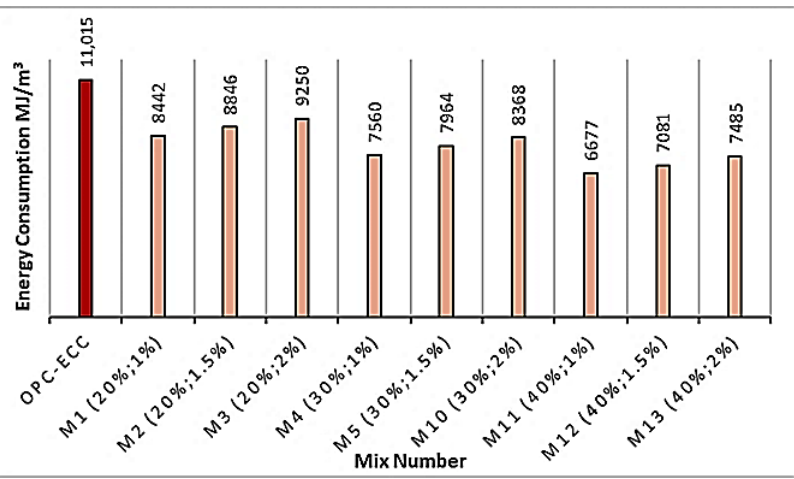
Figure 14. CO 2 emission values of POFA-ECC mixes.